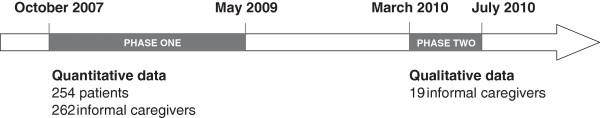
Timeline of data collection.